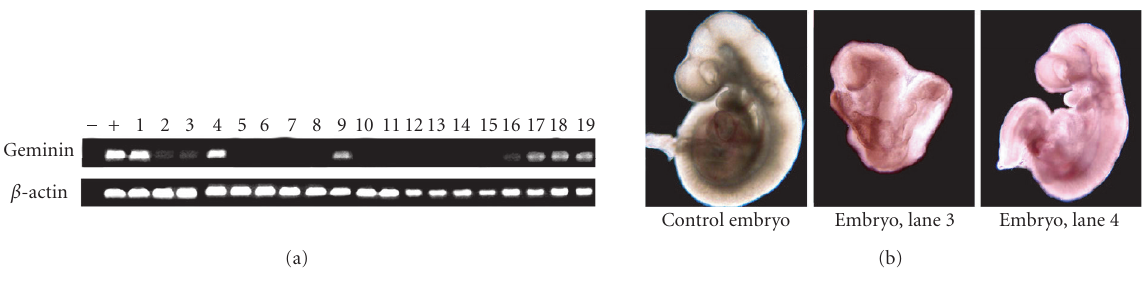
Figure 3: (a) Semiquantitative PCR to detect geminin expression in two entire litters of geminin shRNA- exposed embryos. Some embryos continue to express nearly normal levels of geminin (lanes 1, 4), while others express low (2, 3, 16), intermediate (9, 17–19), or undetectable (5–8, 10–15) levels of geminin . The most advanced embryos consistently expressed the highest levels of geminin . Two entire litters of geminin - targeted embryos were examined; 1–8 and 9–19. − = no RT, + = E9 embryo RNA. (b) Sideview of control and embryos expressing varying levels of geminin